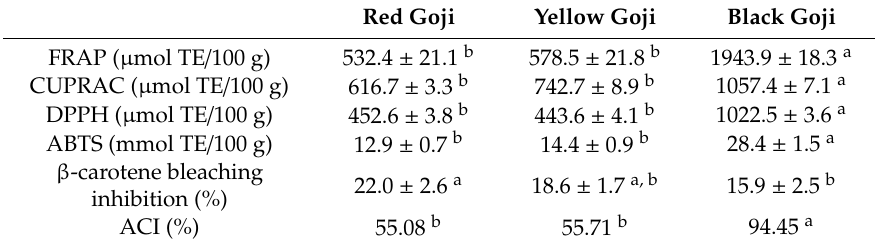
Table 6. Antioxidant activity of studied goji berry fruits (mean ± SD; n =